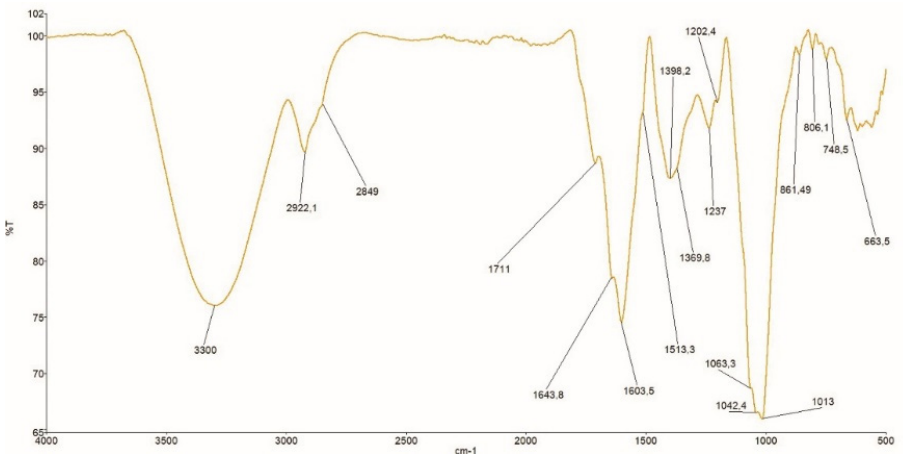
Figure 5. The transmission FTIR spectra of the first extraction (1E) crude dye.